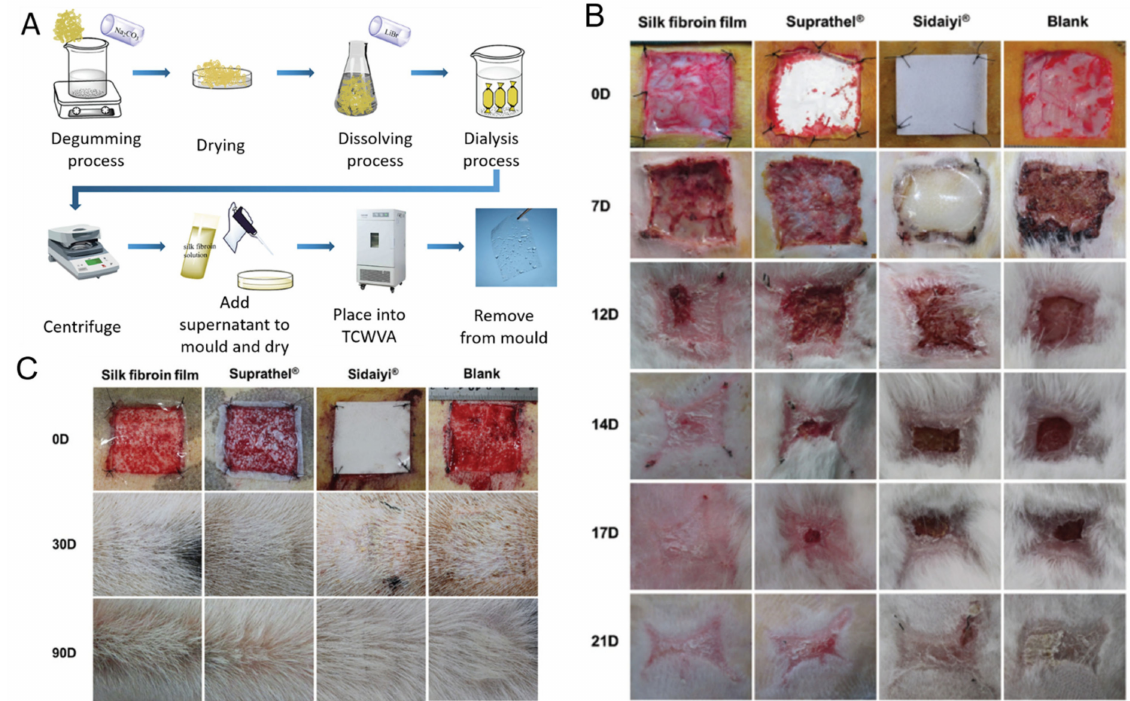
Figure 8. ( A ) Schematic diagram of silk fibroin films via Temperature Controlled Water Vapor annealing (TCWVA). ( B ) RSF films implanted into full-thickness skin defects in rabbit models compared to Suprathel, Sidaiyi, and untreated tissue at 0, 7, 12, 14, 17, and 21 days. ( C ) RSF films implanted into full-thickness skin defects in a porcine model and compared to Suprathel, Sidaiyi, or untreated at 0, 30, and 90 days. Reprinted with permission from